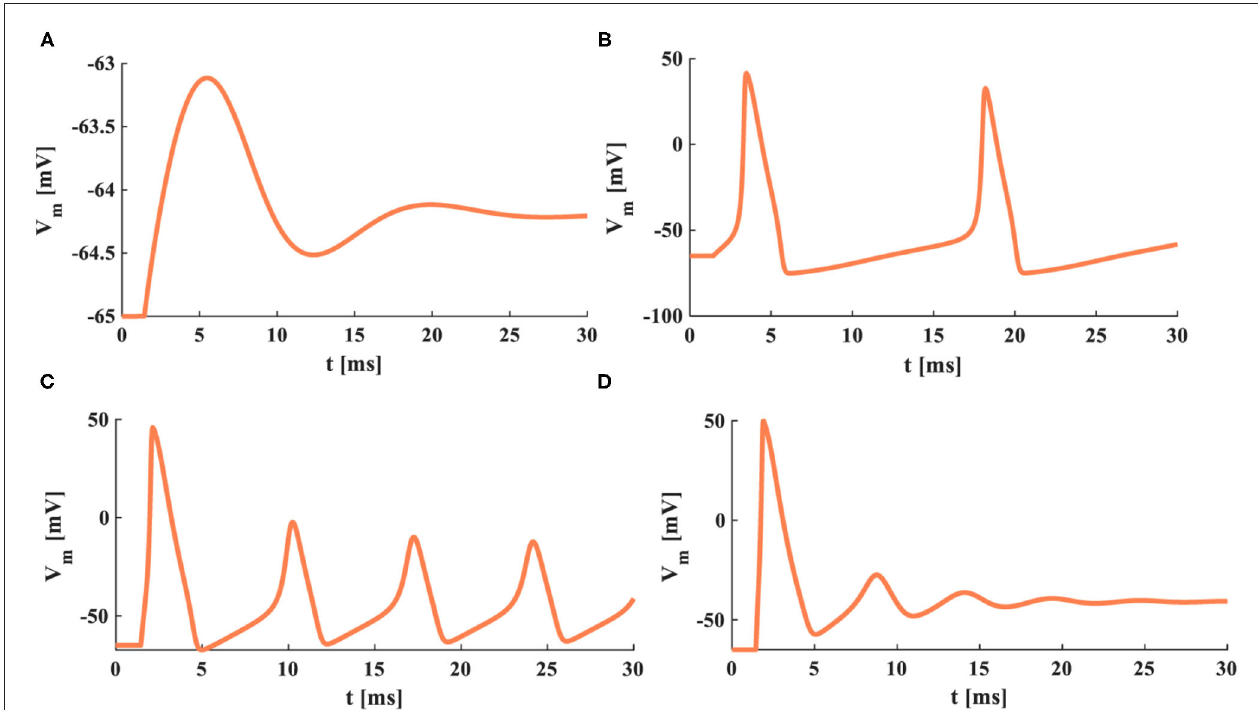
FIGURE 6 | The distinct stimuli are applied to the HH model. (A) The external stimulus is 0.001 mAcm − 2 . (B) The external stimulus is 0.01 mAcm − 2 . (C) The external stimulus is 0.09 mAcm − 2 . (D) The external stimulus is 0.2 mAcm − 2 .